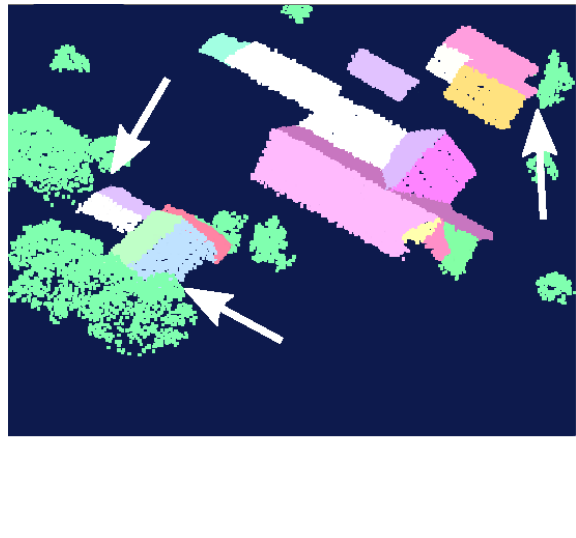
Arrows indicate parts, which are strongly influenced by